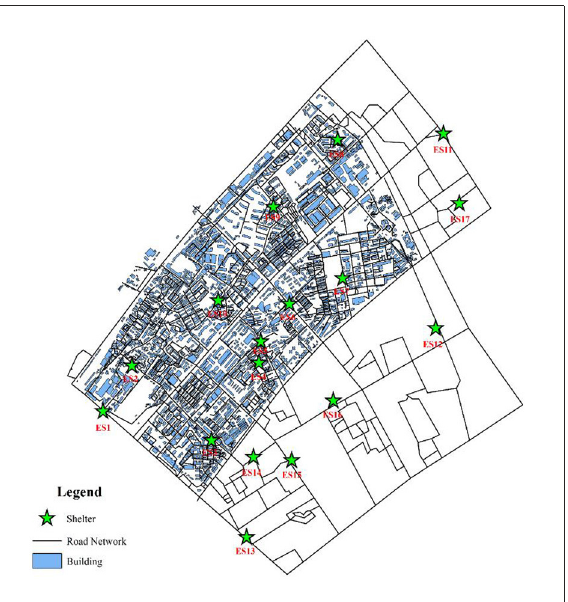
FIGURE8 Facilities distribution of the Yangyuan Street region.